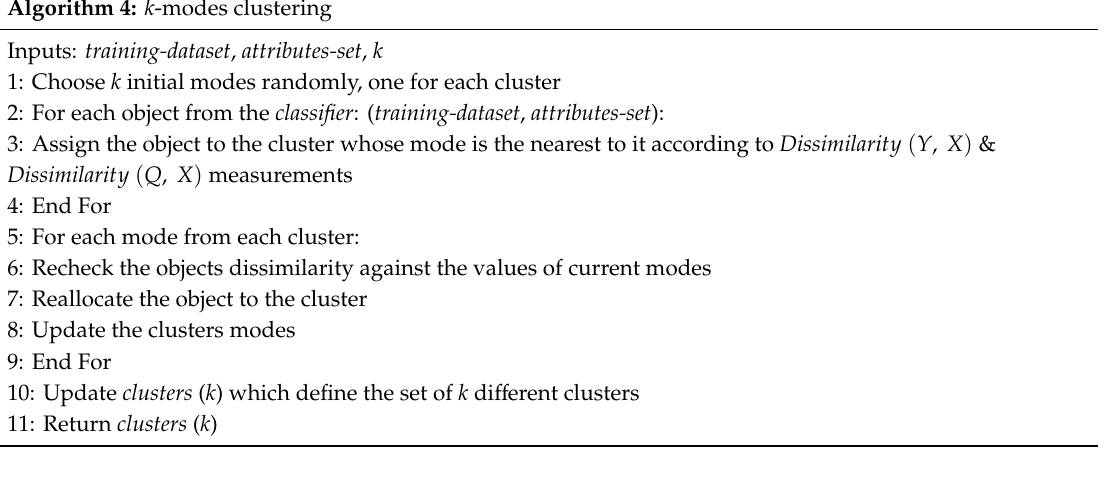
Algorithm 5: Determining λ -